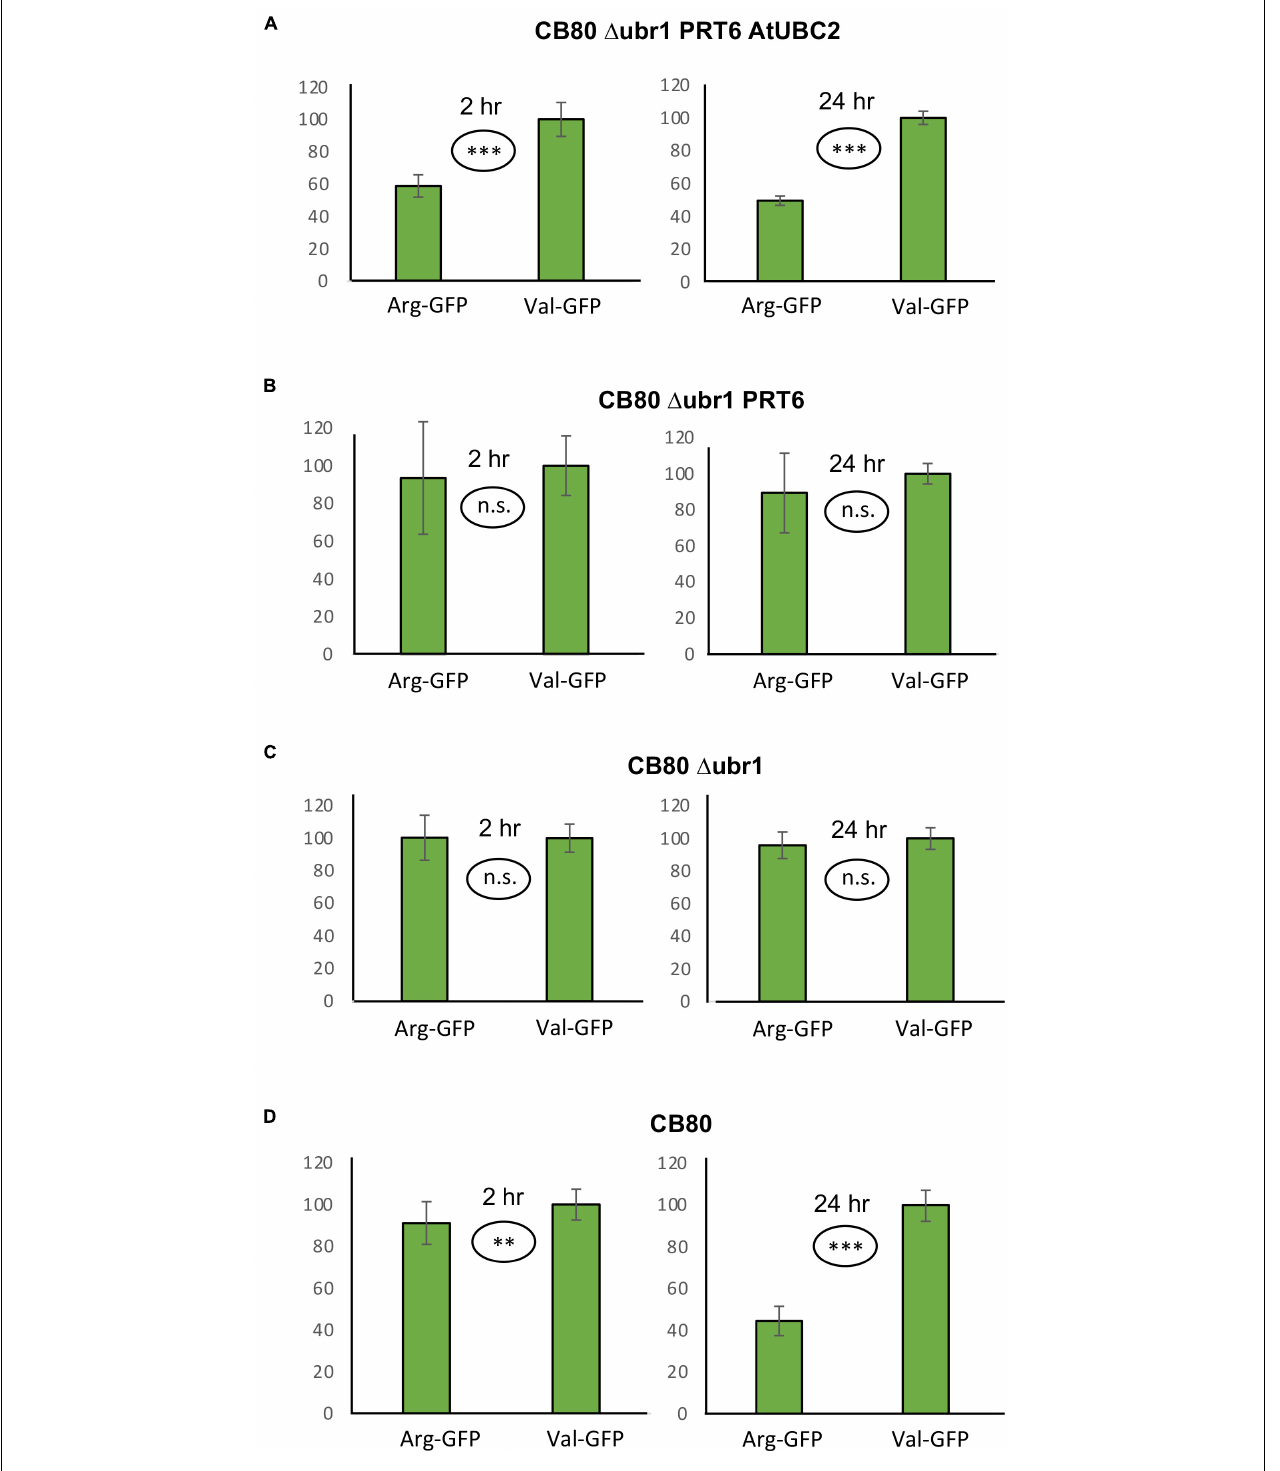
FIGURE 2 | Steady-state levels of GFP-based model substrates starting either with Arg or with Val in different yeast strains. Mean value of Val-GFP was set 100%. Measurements with plate reader were carried out 2 h (right panels) and 24 h (left panels) after inoculation of microtiter wells. Plates were kept at 30 ◦ C to allow yeast growth. Differences in panel (A) (both time points) and panel (D) (24 h time point) are highly significant ( ∗∗∗ p < 0.001, two-sided t test). Difference in panel (D) (2 h time point) is significant ( ∗∗ p < 0.01, two-sided t test). Differences in panels (B,C) are not significant (n.s. p > 0.05, two-sided t test). At least fourteen replicates were used for each column. Numerical data are listed in Supplementary File 6